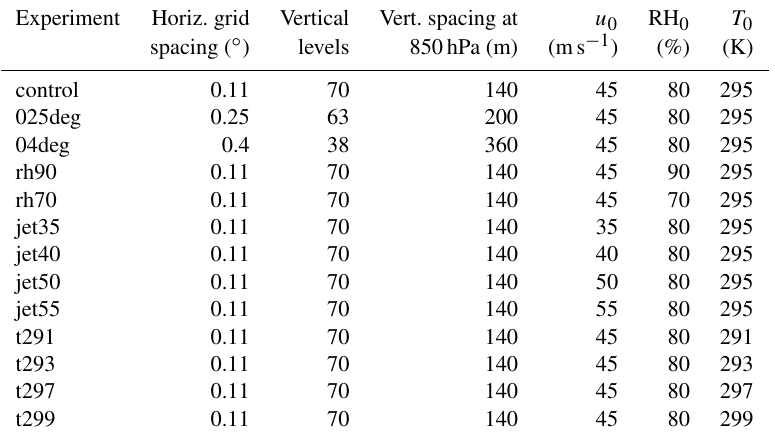
Table 2. Table showing the parameter values chosen for the different experiments. Model top height is 40km for all simulations. u 0 , RH 0 and T 0 indicate, respectively, the maximum initial values of wind speed and relative humidity and the central initial value of surface temperature, as defined in Sect.